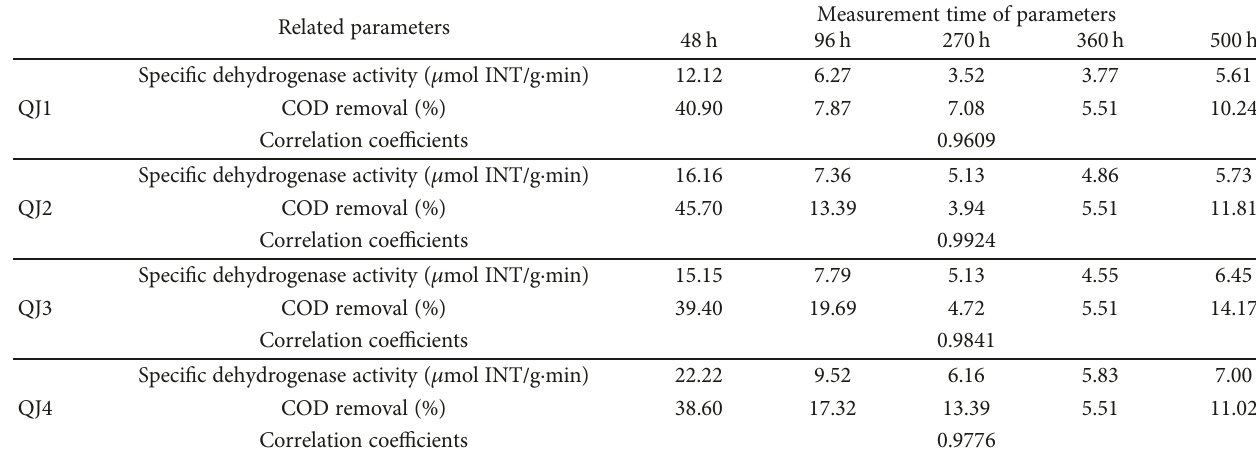
Table 2: Correlation of speci fi c dehydrogenase activity and COD removal. Related